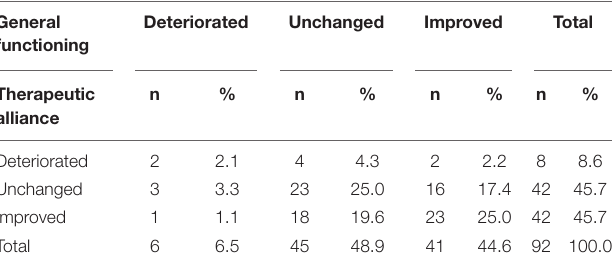
TABLE 1 | The number and percentage of participants that deteriorated, stayed unchanged or improved on the Reliable Change Index (RCI) between first- and last session scores on general functioning (C-ORS) and therapeutic alliance (C-SRS).